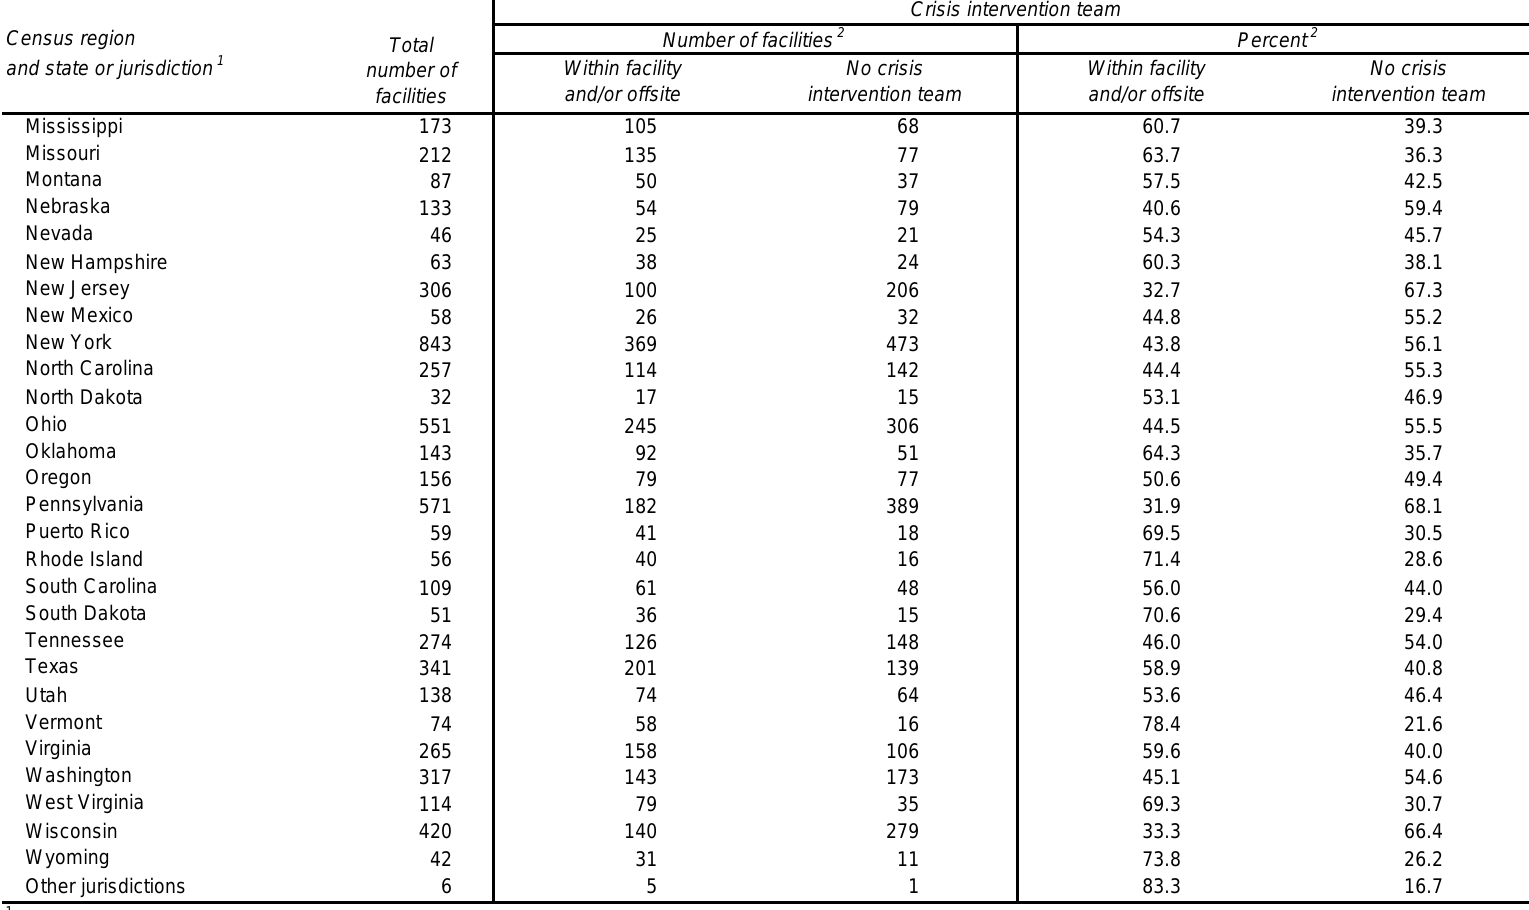
Table 3.12. Mental health treatment facilities that employ a crisis intervention team, by Census region and state or